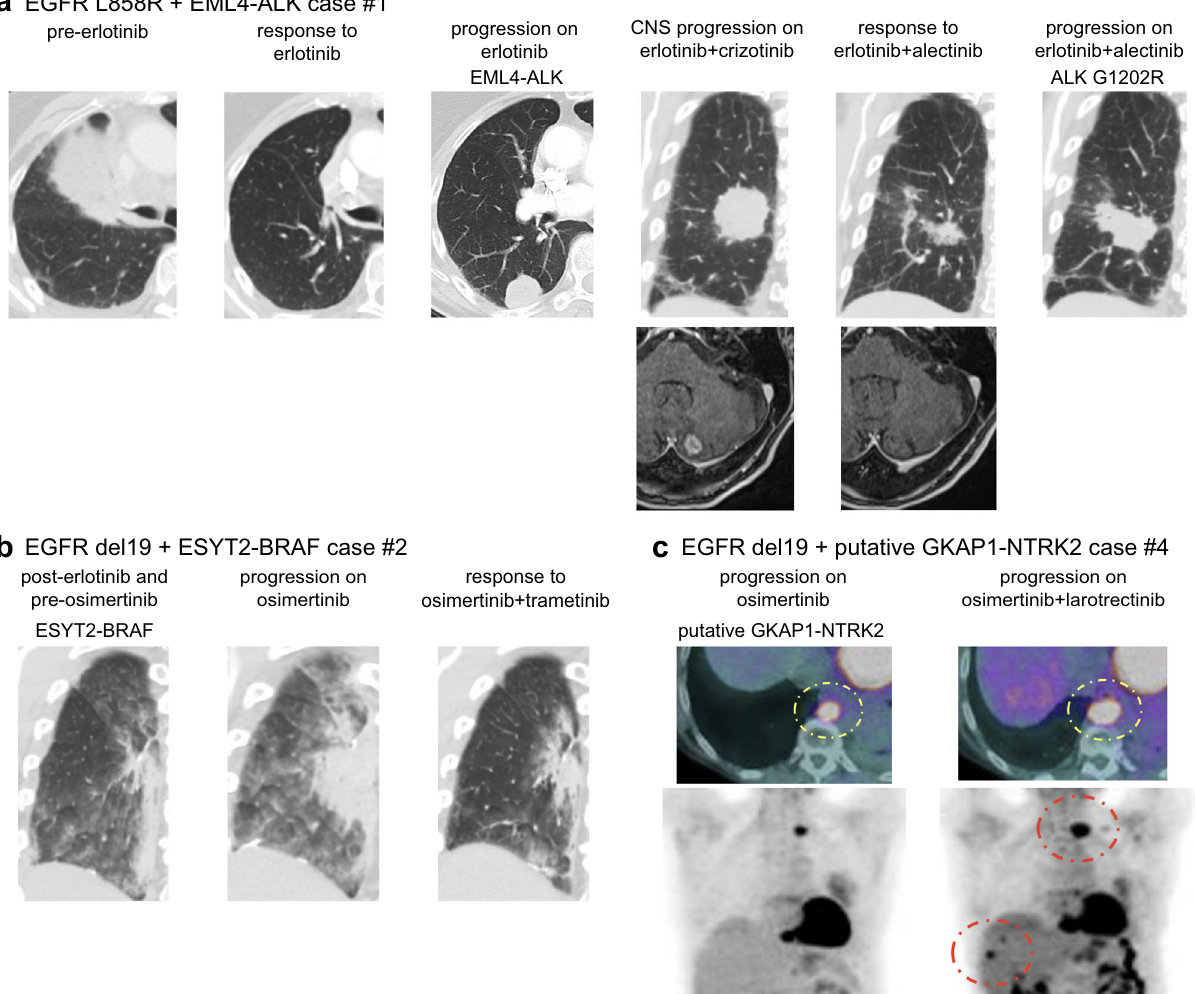
EGFR exon19deletion(del19)lungadenocarcinoma,whichhadacquiredan ESYT2- BRAF fusion. c Positron emission tomography (PET)-CT images show the progres- sion of EGFR del19 adenocarcinoma with a putative GKAP1-NTRK2 fusion